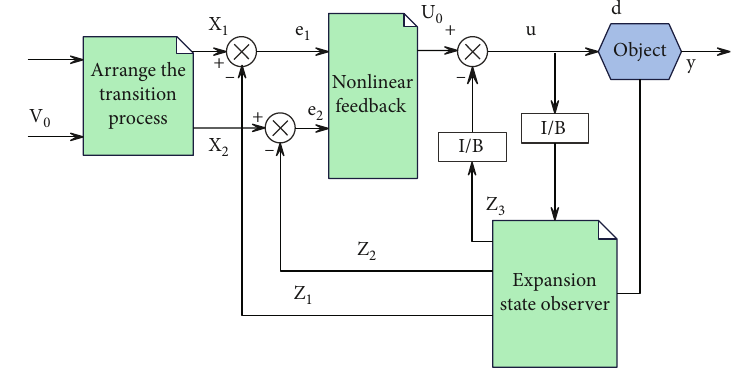
Figure 2: Structure diagram of the second-order ADRC